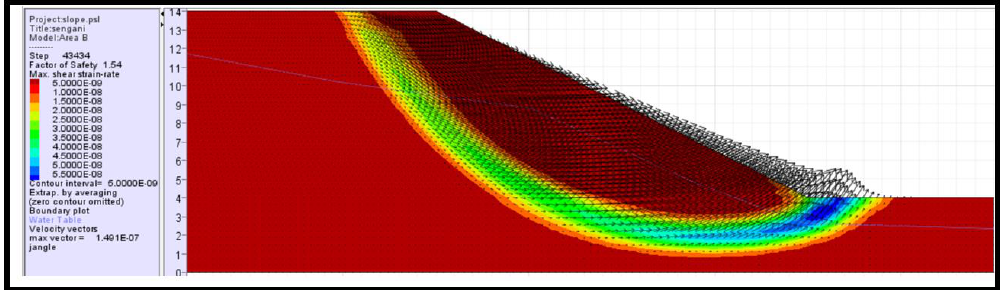
Figure 25. Simulated FoS of the silt clay soil slope using FLACSlope in rainy conditions with a water table with 2000 m 3 volume of water. Note that maximum shear strain simulated ranges between 5.000 × 10 − 9 to 1.491 × 10 − 7 .